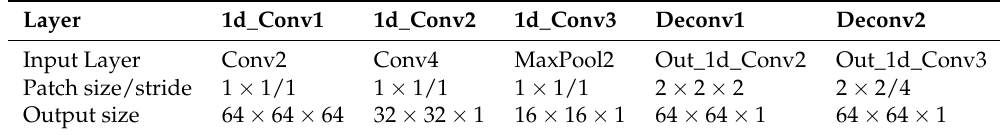
Table 2. Upsampling component network parameters.